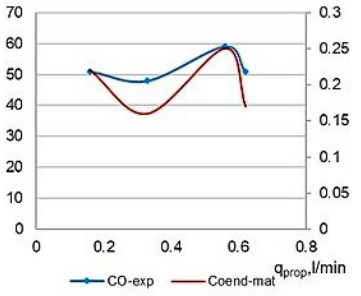
Figure 34. Comparision Tend in experiment and modelling at the outlet depends on propane injection